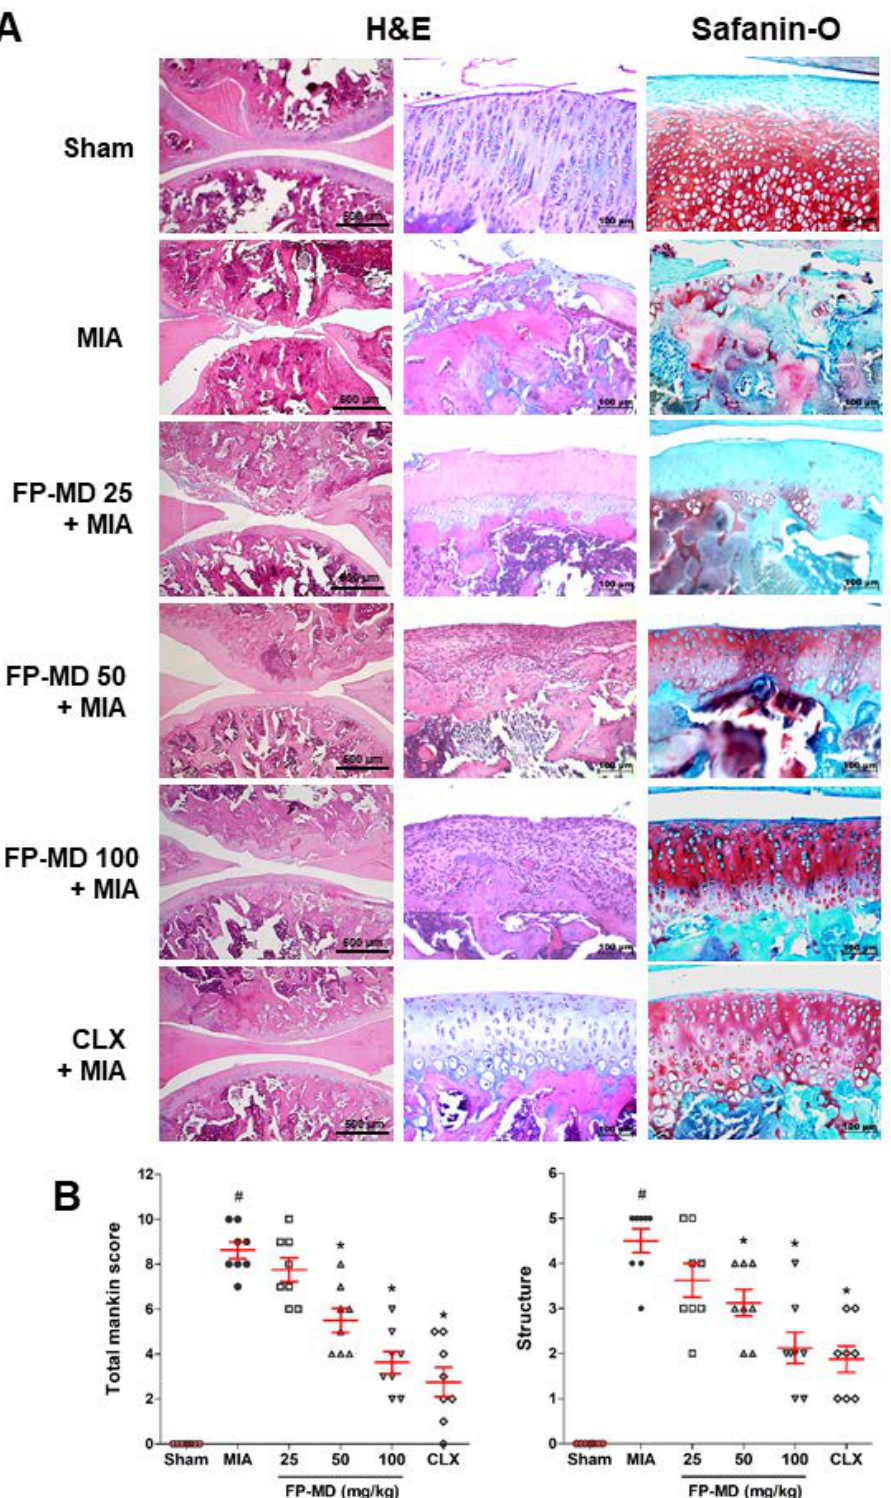
Figure 2. Histological evaluation of joints activity after administration with FlexPro MD ® (FP-MD) in monosodium iodoacetate (MIA)-induced osteoarthritis (OA) rats. ( A ) Knee joints of the OA rats were stained with hematoxylin and eosin (H&E) and Safranin O-Fast green. ( B ) The joint lesions were graded on a scale of 0–13 using the modified Mankin’s scoring system, giving a combined score for cartilage structure. Data are expressed as the mean ± S.E.M ( n = 8). # p < 0.05 versus vehicle-treated Sham group and * p < 0.05 versus MIA. CLX; celecoxib 3 mg/kg-treated.